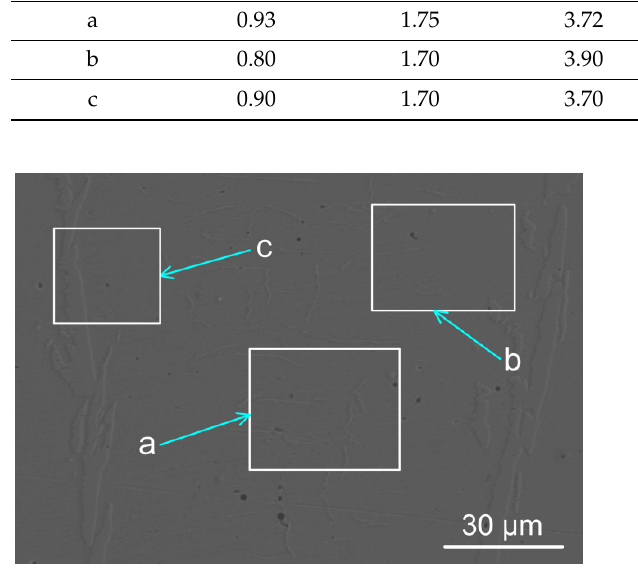
Table 4. SEM-EDS analyses of marked areas in the weld metal as indicated in Figure 1 (mass%). Table 3. Weld metal compositions (mass%).